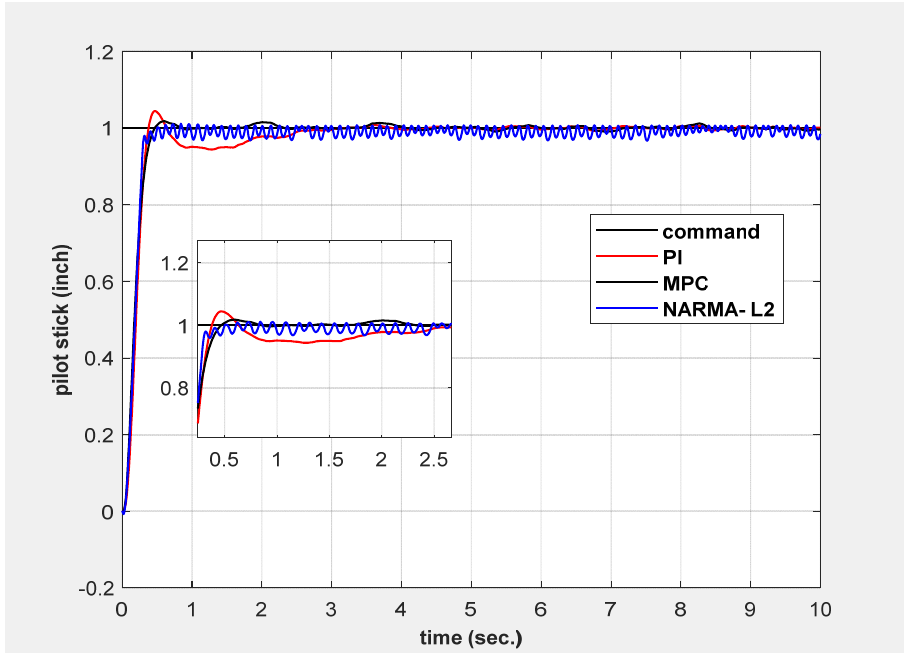
Figure 26. System response based controllers with disturbance.